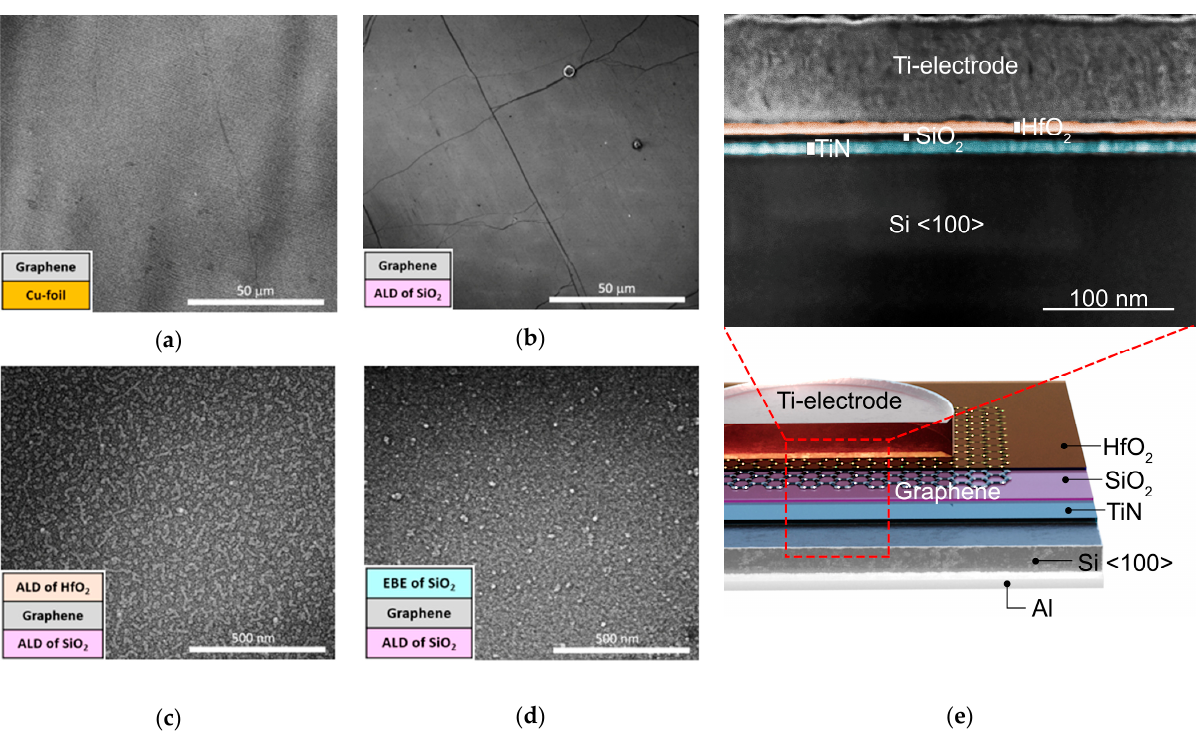
Figure 2. Bird’s-eye-view of SEM images of the surfaces of the graphene layer, as deposited on Cu foil ( a ), graphene transferred to ALD-grown SiO 2 film ( b ), ALD-grown HfO 2 film on graphene ( c ), electron beam evaporated SiO 2 film on graphene ( d ), and cross-sectional image (the dark field, obtained in STEM mode of SEM) of a thin lamella prepared from the SiO 2 /Graphene/HfO 2 (Sample 3 in Table 1) stack structure ( e ). Note that graphene is not visible in this image at this resolution. The oxide layers in the image have been false-colored to make the distinction between them